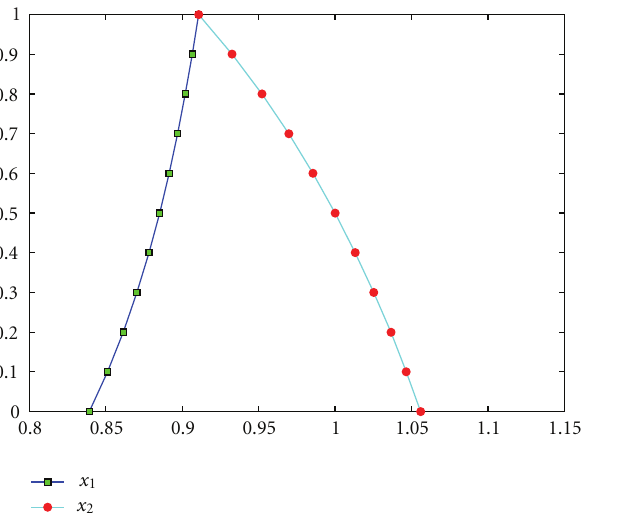
Via Algorithm 5 with x 0 = (0 . 4,0 . 5,0 . 6) by repeating 3